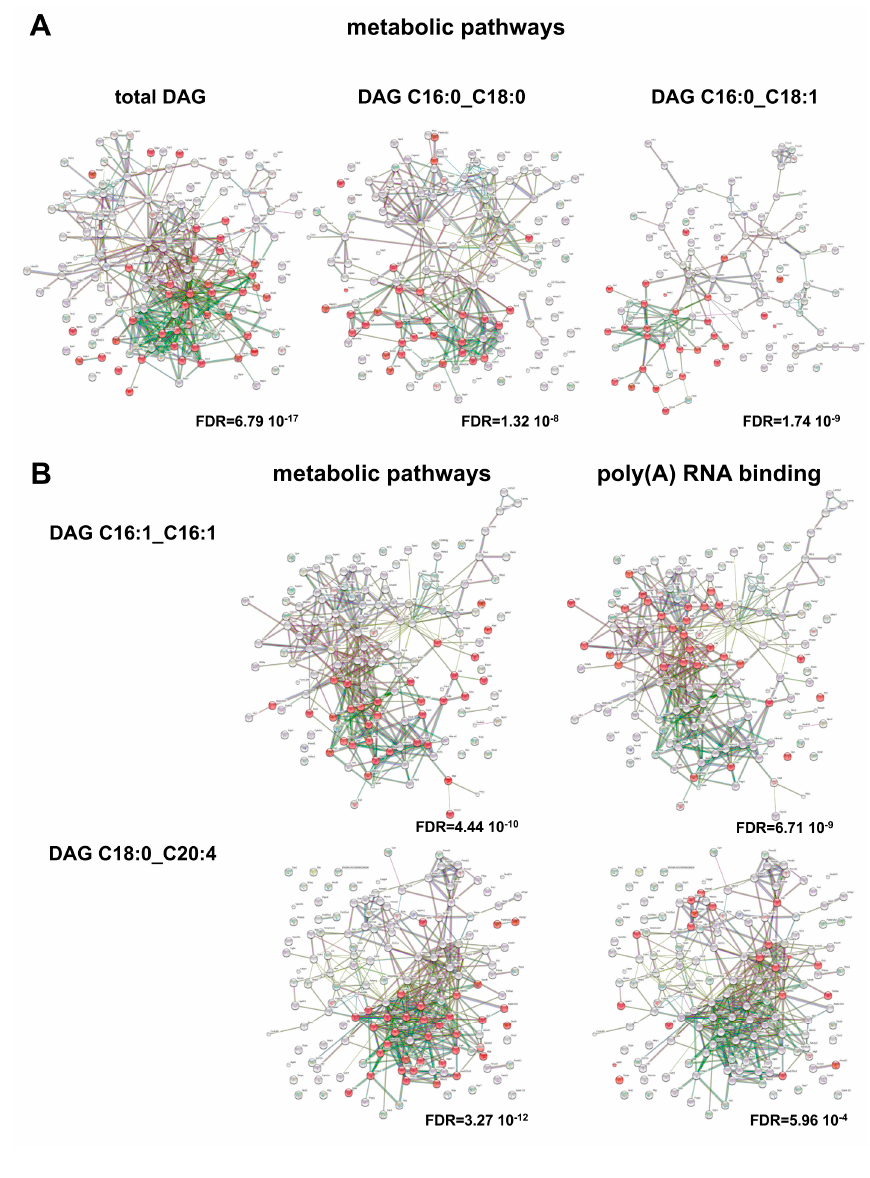
Figure 5. Functional network of adipokines correlated to DAG species. Adipokines with significant correlation to total DAG content or indicated DAG species were used for over representation analyses.